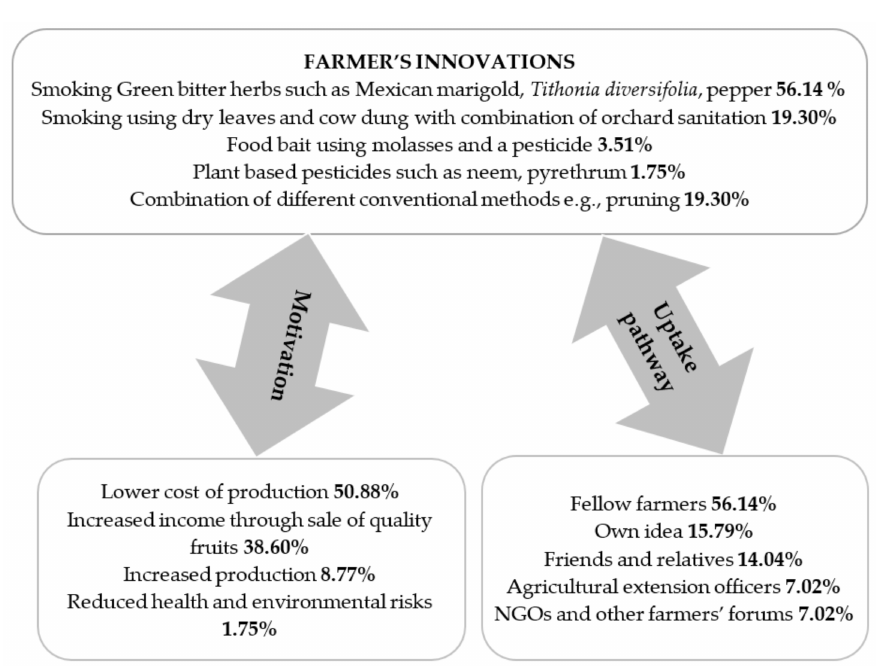
Figure 4. Farmers (cid:48) innovations for the management of the mango fruit